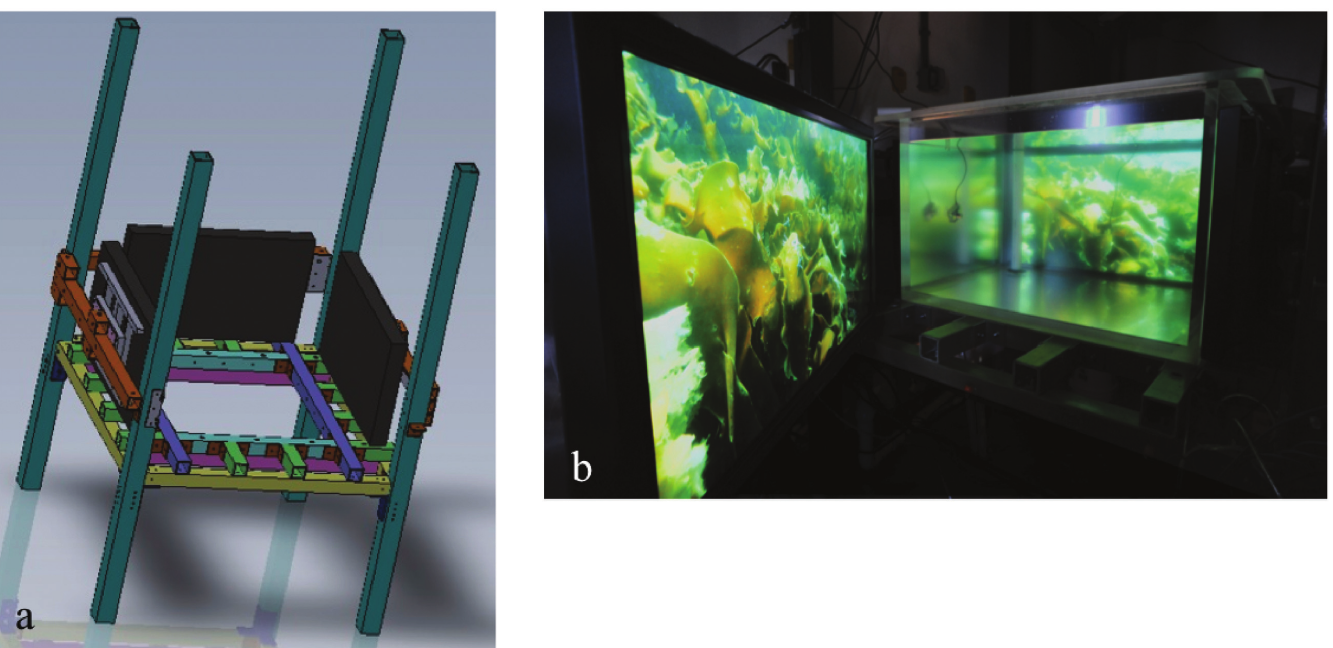
Fig 2. Sub Sea Holodeck. a. Schematic rendering of the Holodeck, with only three sides shown for clarity. b. Actual image of the Holodeck, showing the vertical planes adjacent to the tank sides. The horizontal stimulus DLP screens are not shown. Both images taken from [21]. Reprinted from [21] with permission from IEEE, original copyright 2015.